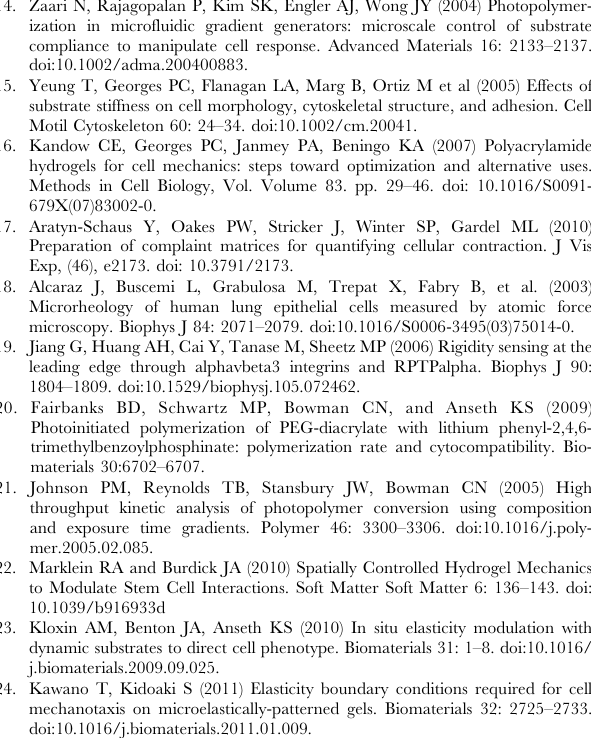
from 50 to 17 kPa/mm. Error bars in each hydrogel represent SE of 3 replicates. (TIF) Figure S2 Examples of irradiation profiles obtained by moving the mask using different speed protocols. The method presented here is suitable for obtaining linear (A), exponential (B) and general monotonically decreasing (C) irradiation profiles. Dashed line in panels A–C indicates the initial position of the mask. These data have been obtained by imaging the real movement of the mask and then summing all recorded frames. Bottom panels display the mask speed protocol used to obtain the linear (D), the exponential (E) and the general monotonically decreasing (F) irradiation profiles shown in A–C panels. (TIF) Figure S3 Correction for non-linear relation between irradiation and stiffness. (A) From the data in the calibration curve (Fig. 2C), we ascertain the irradiation pattern (solid line) that produces a linear stiffness hydrogel (dashed line). (B) Sketch representing the moving mask setup at time t . The edge of the mask is positioned at x ( t )= x and is moved at a speed v ( t )= v . L is the hydrogel length and T is the maximum irradiation time (i.e. T is the time that needs the edge of the mask to travel from x = 0 to x = L ). The exposure time of the hydrogel at position x is given by T – t x , where t x is the time at which the mask arrives at gel position x . Figure S4 Hydrogel stiffness profiles are reproducible. Spatial map of elasticity of hydrogels produced on different days with different solutions of acrylamide/ bis-acrylamide/Irgacure. (TIF)